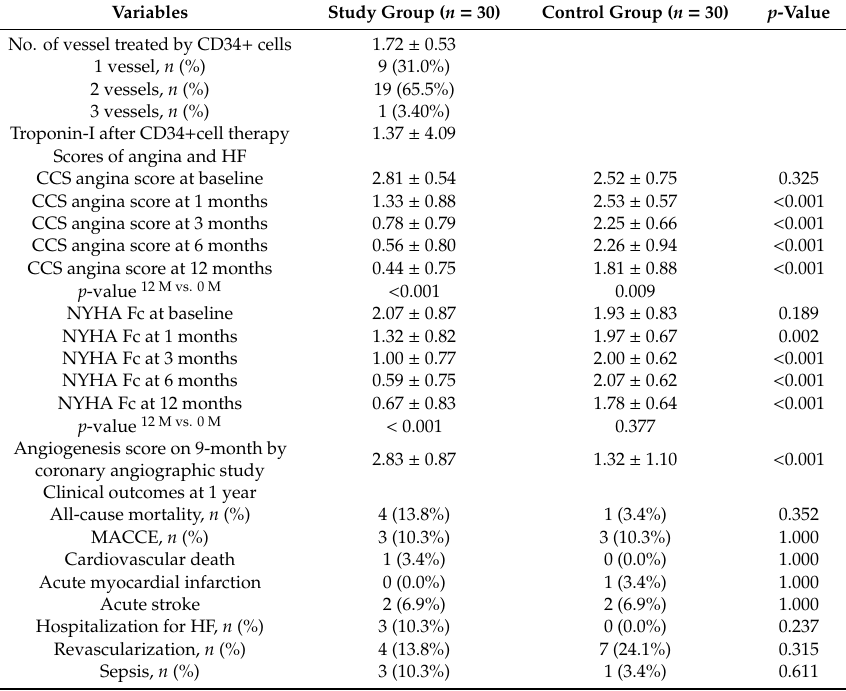
Table 2. Clinical and Angiographic Findings and Prognostic